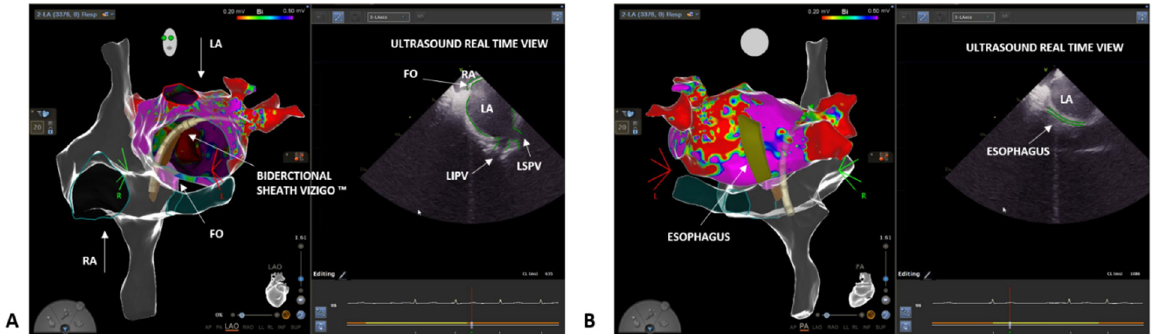
Figure 3. Detailed reconstruction of both right (glass mode) and left atrium (bipolar map) anatomy of the second case thanks to a combination of Carto 3 ® EAM system, ICE, and CartoSound ® module in a LAO projection and in a postero-anterior projection. Accurate identification of pulmonary veins ( A ) and esophagus location ( B ) on ICE images and co-registration with the electro-anatomical maps using CartoSound ® module. FO = fosa ovalis; LA = left atrium; LIPV = left inferior pulmonary vein; LSPV = left superior pulmonary vein; RA = right atrium